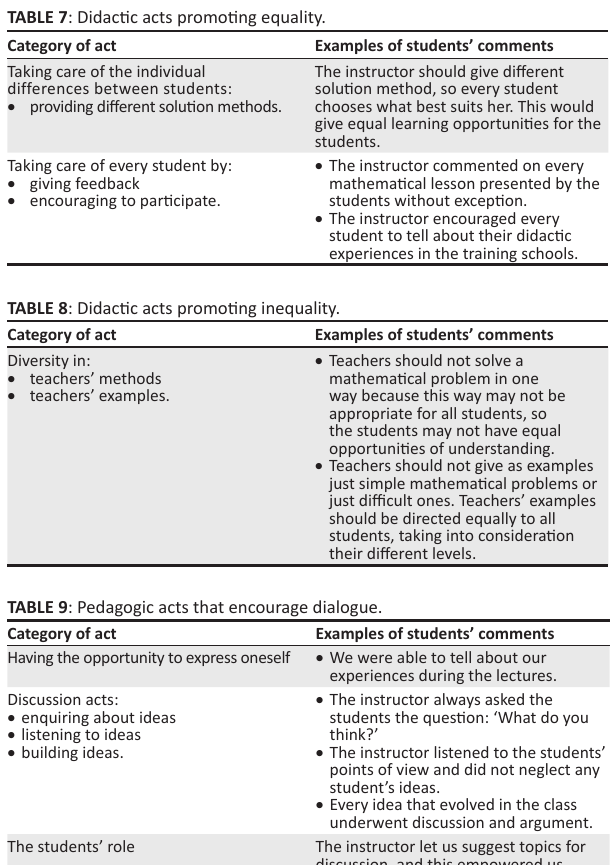
The students’ role